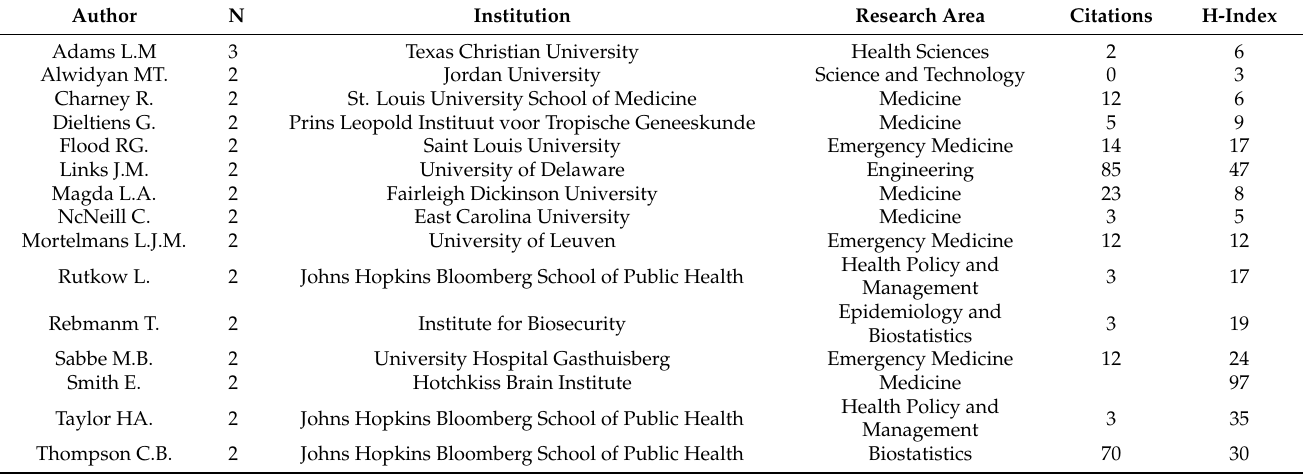
Table 1. Patterns of authors, institution, research area, citations, and H-index (Scopus).